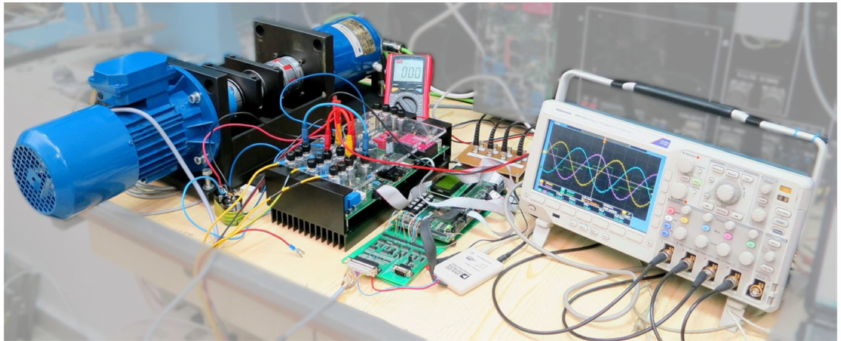
Figure 2. Photography of the laboratory